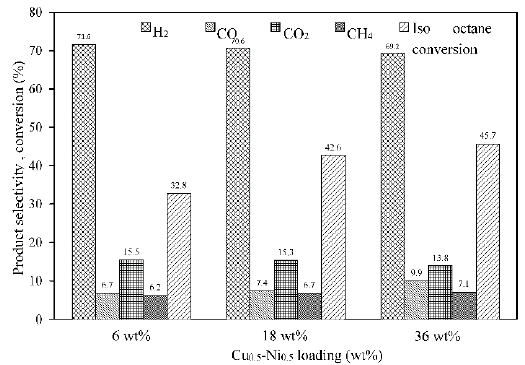
Figure 10. Effect of Ni 0.5 ‐ Cu 0.5 /Al 2 O 3 catalysts on conversion and product selectivity with varying Ni 0.5 ‐ Cu 0.5 /Al 2 O 3 ratios: T = 550 °C; N 2 = 15 cm 3 /min, iso ‐ octane feed rate was 0.03 g/min; S/C molar ratio: 0.9.